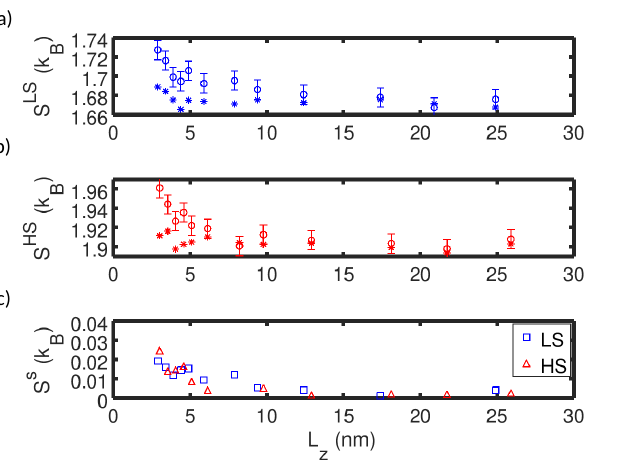
Figure 4. Size evolution of the “total” (open circles) and the “bulk” (stars) vibrational entropies S N and S b for ( a ) the LS and ( b ) the HS states. The error bar represents the numerical uncertainties due N to the vacuum creation (for the calculation details, see Supplementary Materials, Section S5). ( c ) Size evolution of surface vibrational entropy S s of the LS (blue squares) and HS (red triangles) N